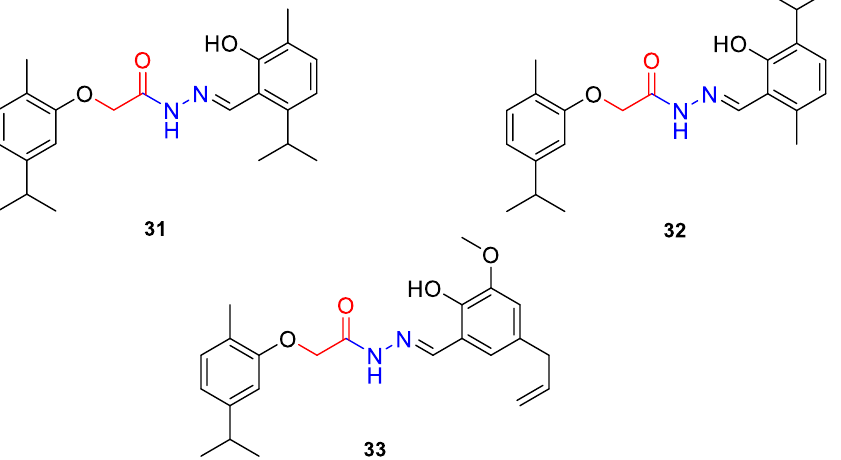
Figure 17. Carvacrol hydrazone derivatives with anticancer potency against pancreatic and colon cancers.